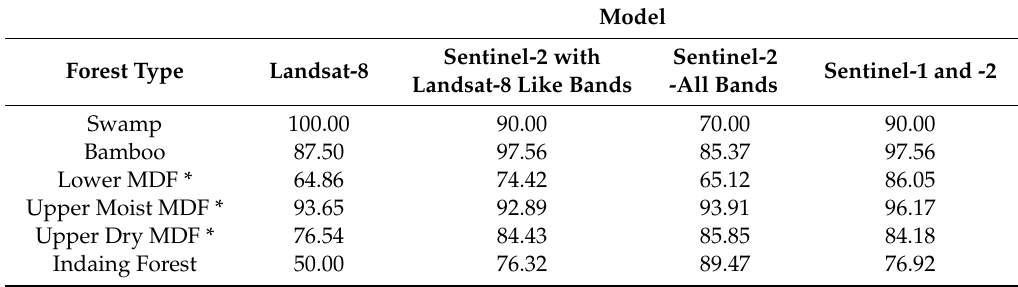
Table 6. User’s accuracy for each forest type in each model in separating forest types in the Bago Yoma of